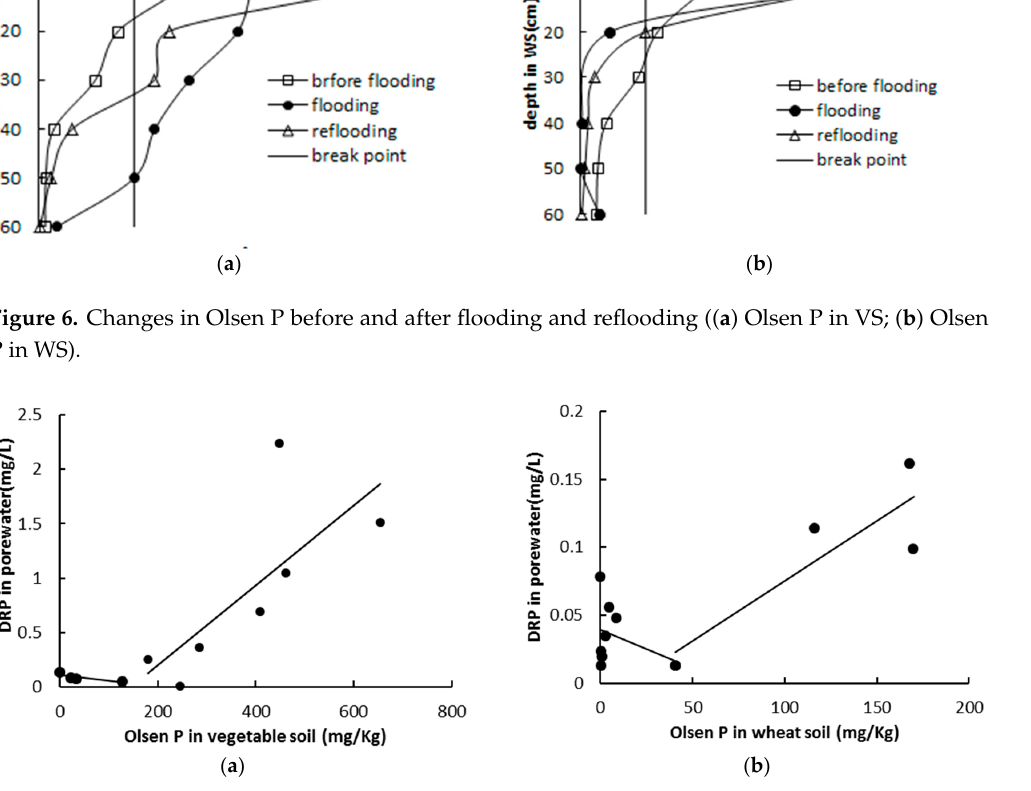
Figure 7. Relationships between Olsen P and DRP in pore water (( a ) VS; ( b ) WS).